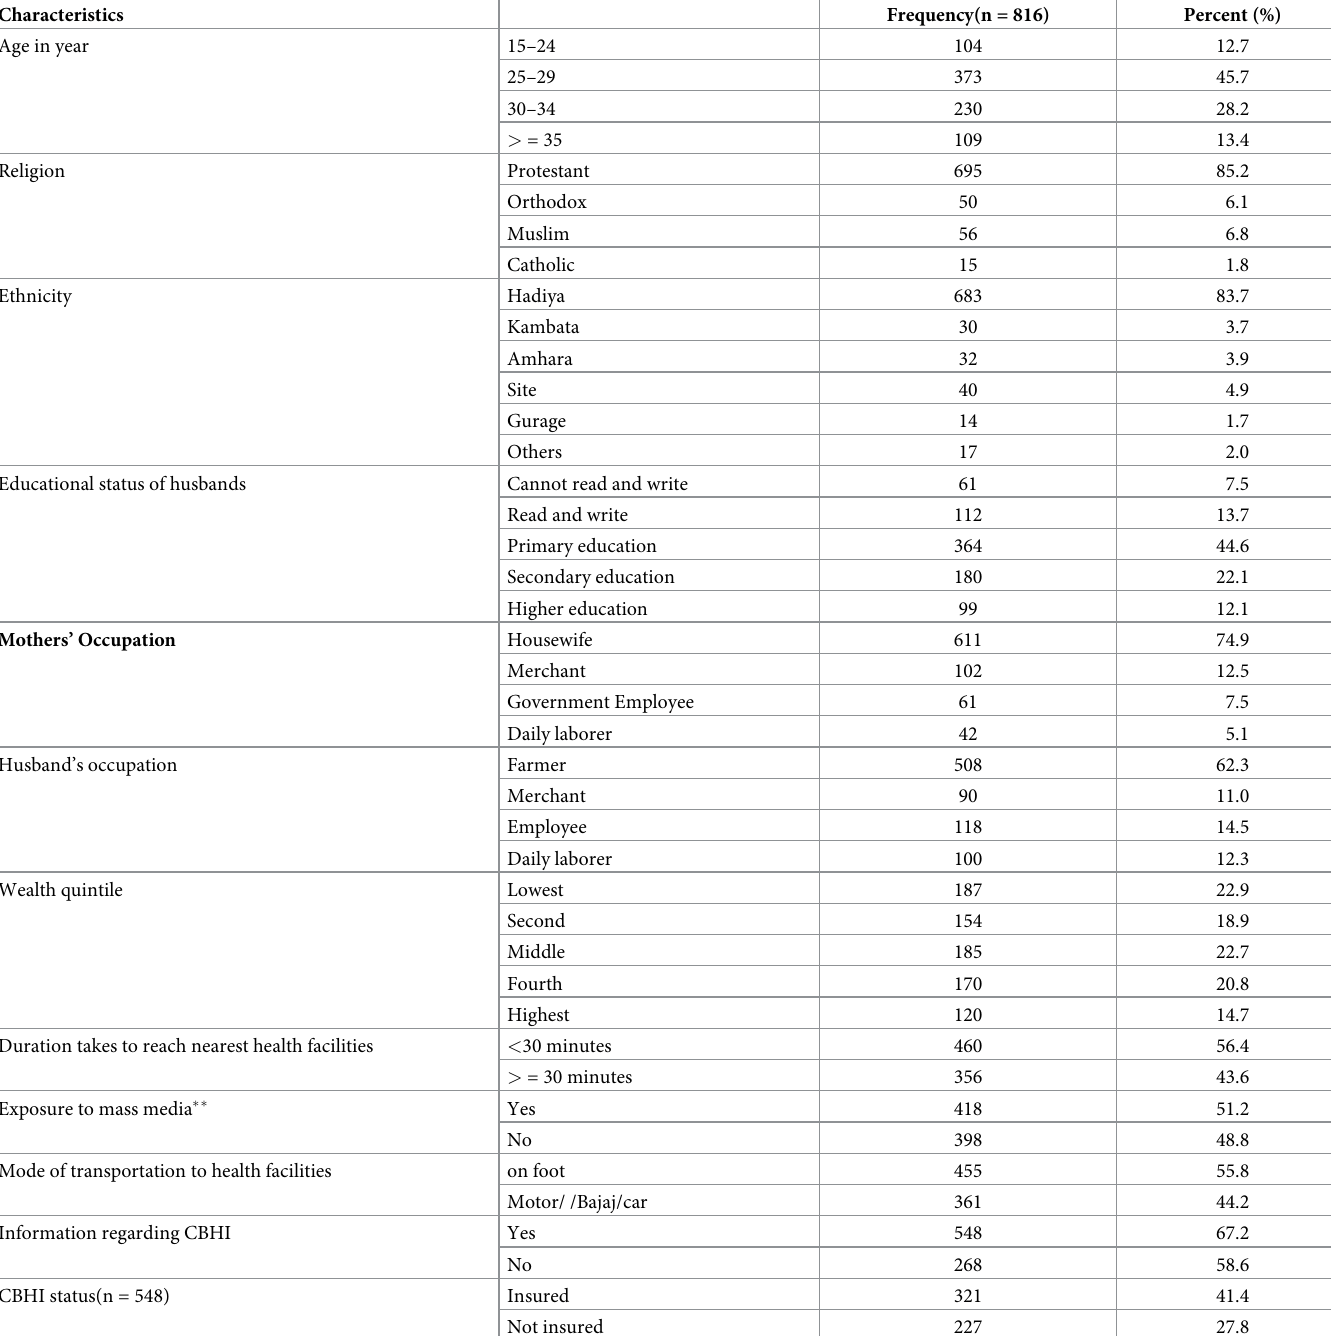
Table 1. Socio-demographic characteristics of mothers who have given birth in the last 12 months in the Hadiya zone, 2021.